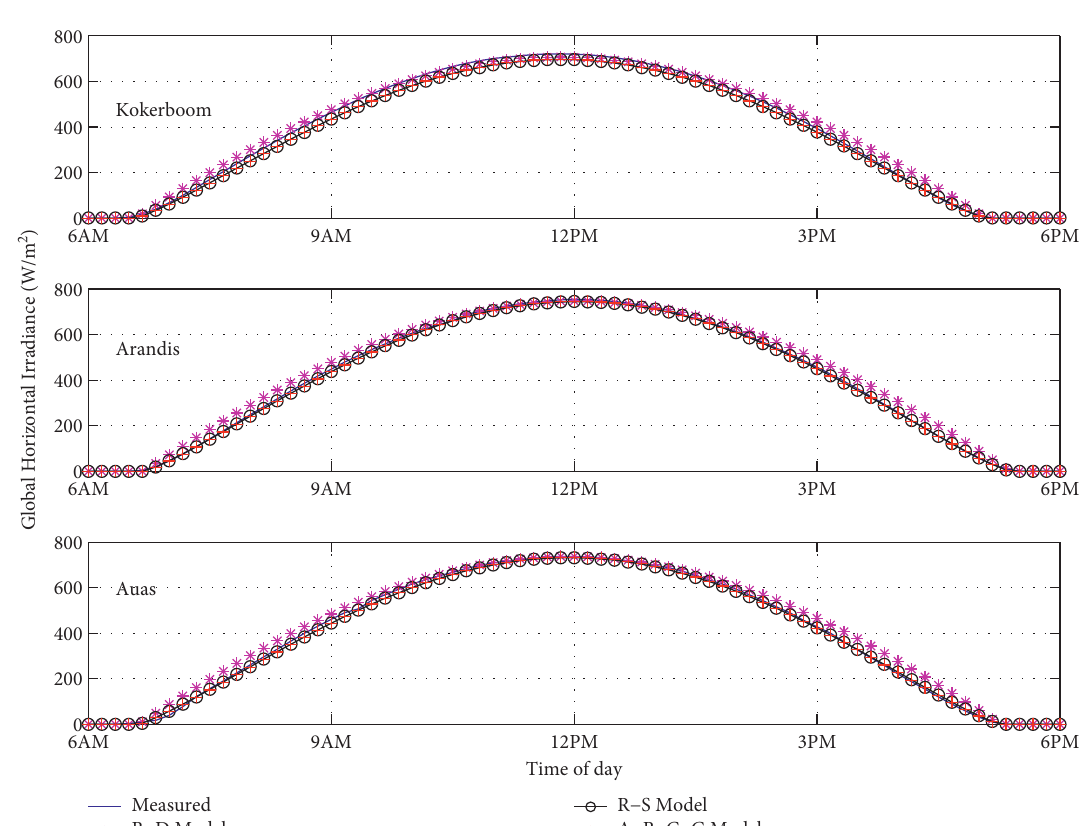
Figure 4: Modelled and measured irradiance on typical clear sky days at Kokerboom, Arandis, and Auas.